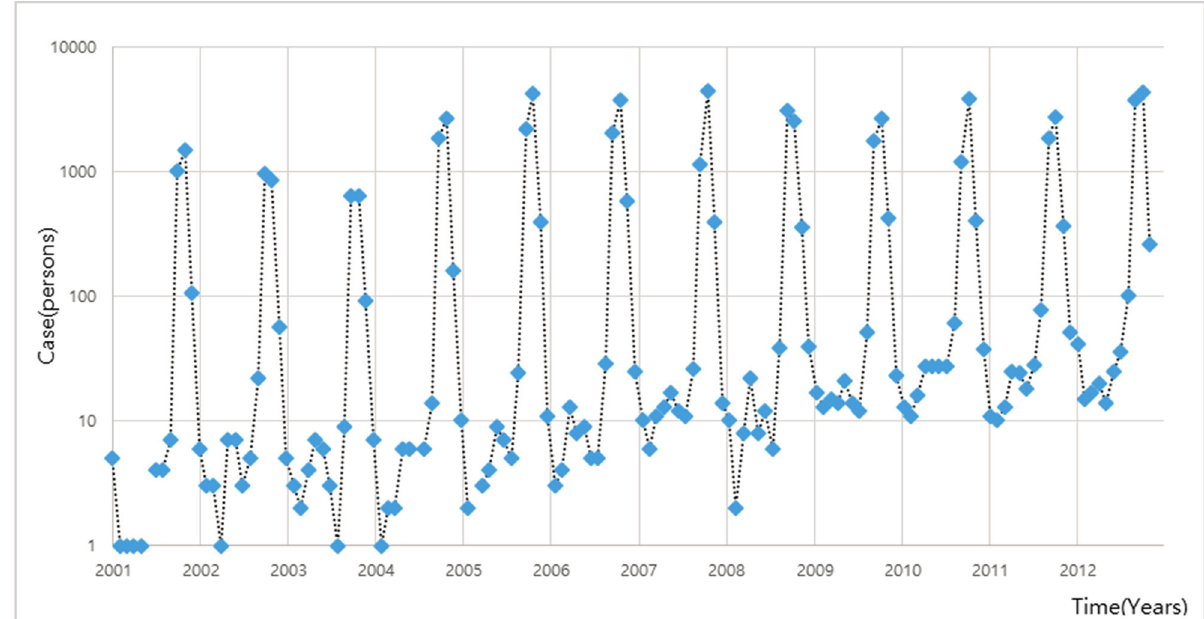
Figure 3. Scrub typhus incidence cases in Korea